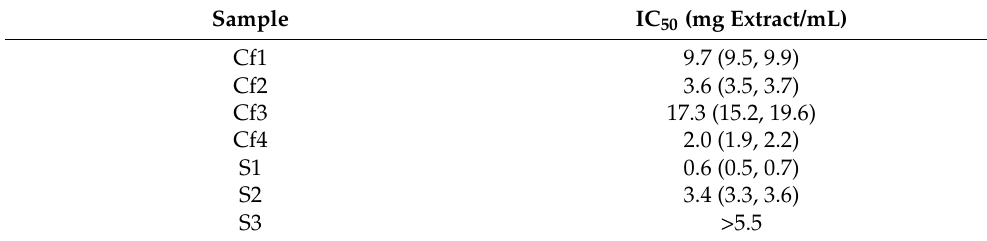
Table 6. IC 50 values obtained for all the extracts in HaCaT cells, with 24 h incubation. IC 50 values are expressed as mean with a 95% confidence